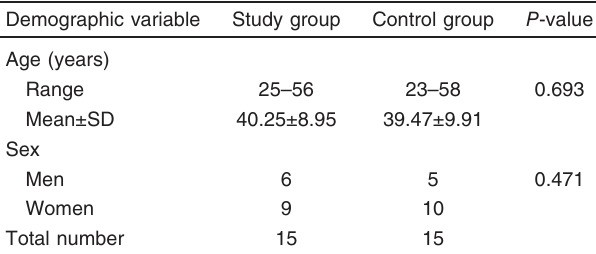
Table 1 Demographic criteria of the study group versus the control group Demographic